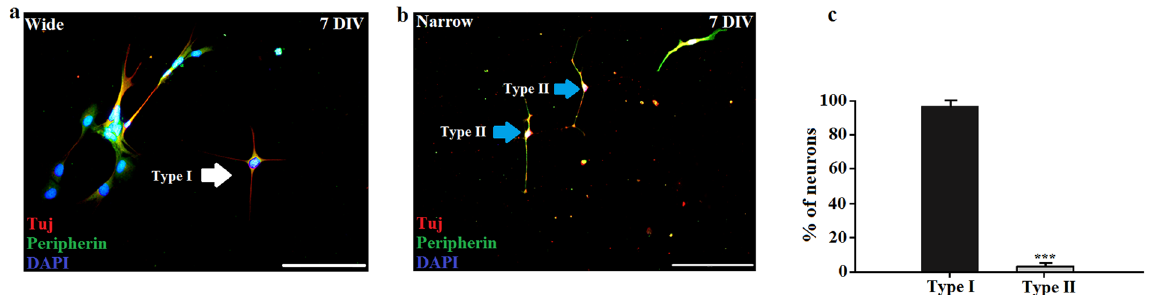
Figure 8. Presence of Type I and Type II of adult SGNs. ( a ) and ( b ) Fluorescent images of guinea pigs type I and II SGNs on CMOS chips: Neurons stained with neuronal marker Tuj (red) and the nuclear marker DAPI (blue). Type II SGNs stained with peripherin (green) and the nuclear marker DAPI (blue). The white arrow shows Type I SGNs and blue arrows show Type II SGNs from guinea pigs. Scale bars: 200 µ m. ( c ) Percentage of Type II SGNs from guinea pigs in comparison with Type I SGNs (M = 3, N = 18, n = 386). *** P < 0.001 (Student’s